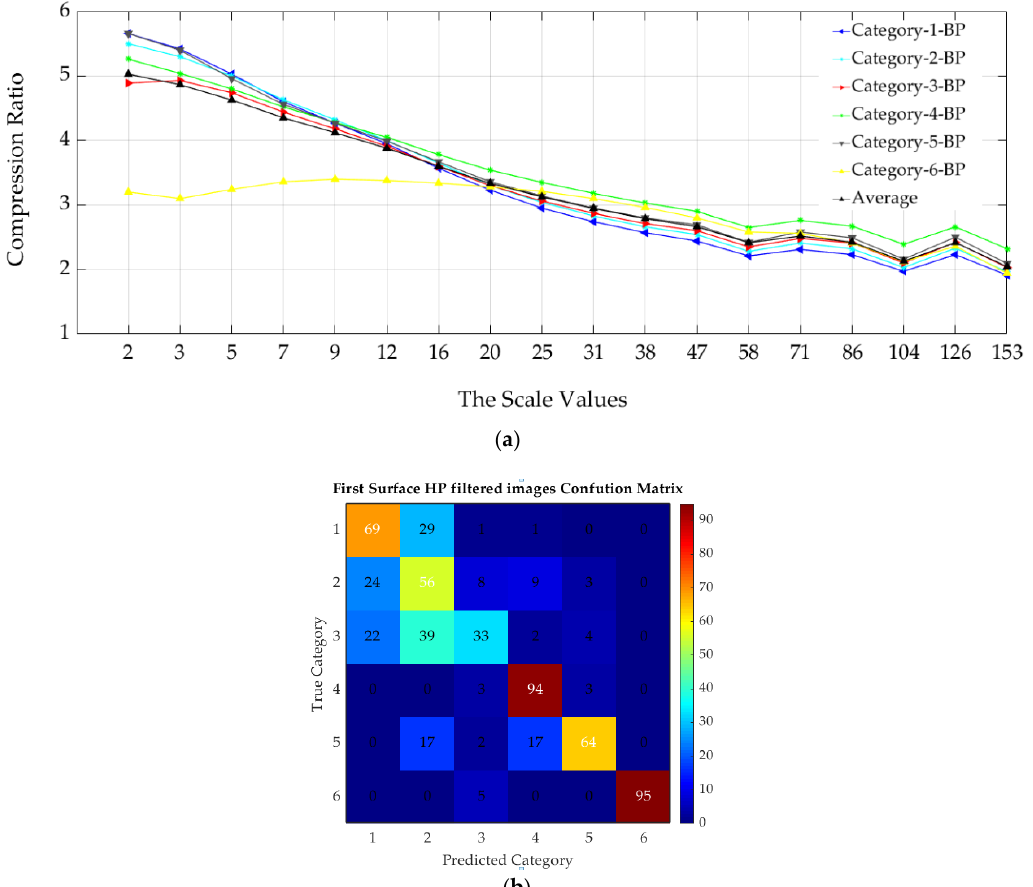
Figure 26. The impact of scale of analysis on the performances of a compressed-domain classifier: ( a ) the relation between the scale of analysis and the six surface categories’ compression and classification performances by using the multiscale LP data sets and ( b ) a confusion matrix for six surface category. classifications by using 50% of the highest-scale LP data set for training.